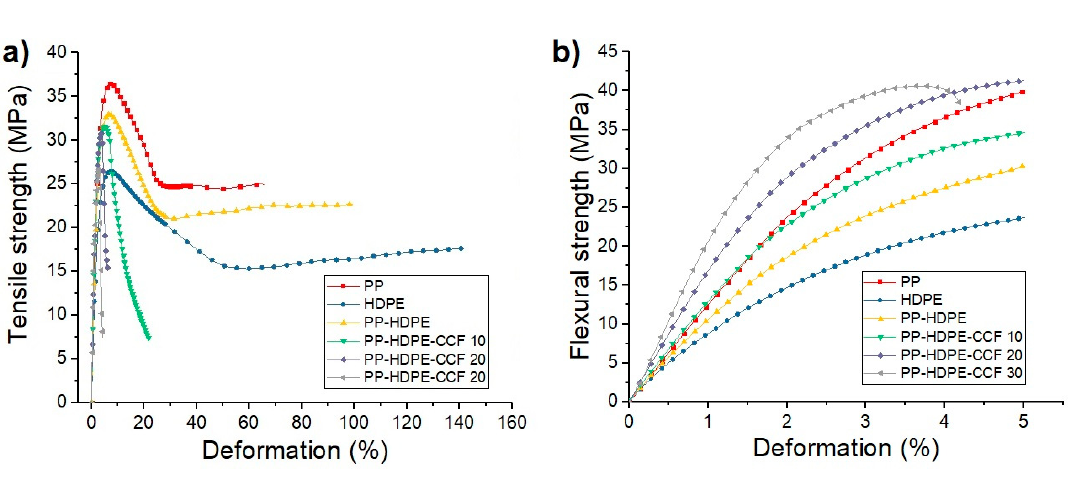
Figure 6. Average tensile stress vs deformation ( a ) and flexural stress vs deformation ( b ) of PP, HDPE, PP-HDPE blend, and their biocomposites.